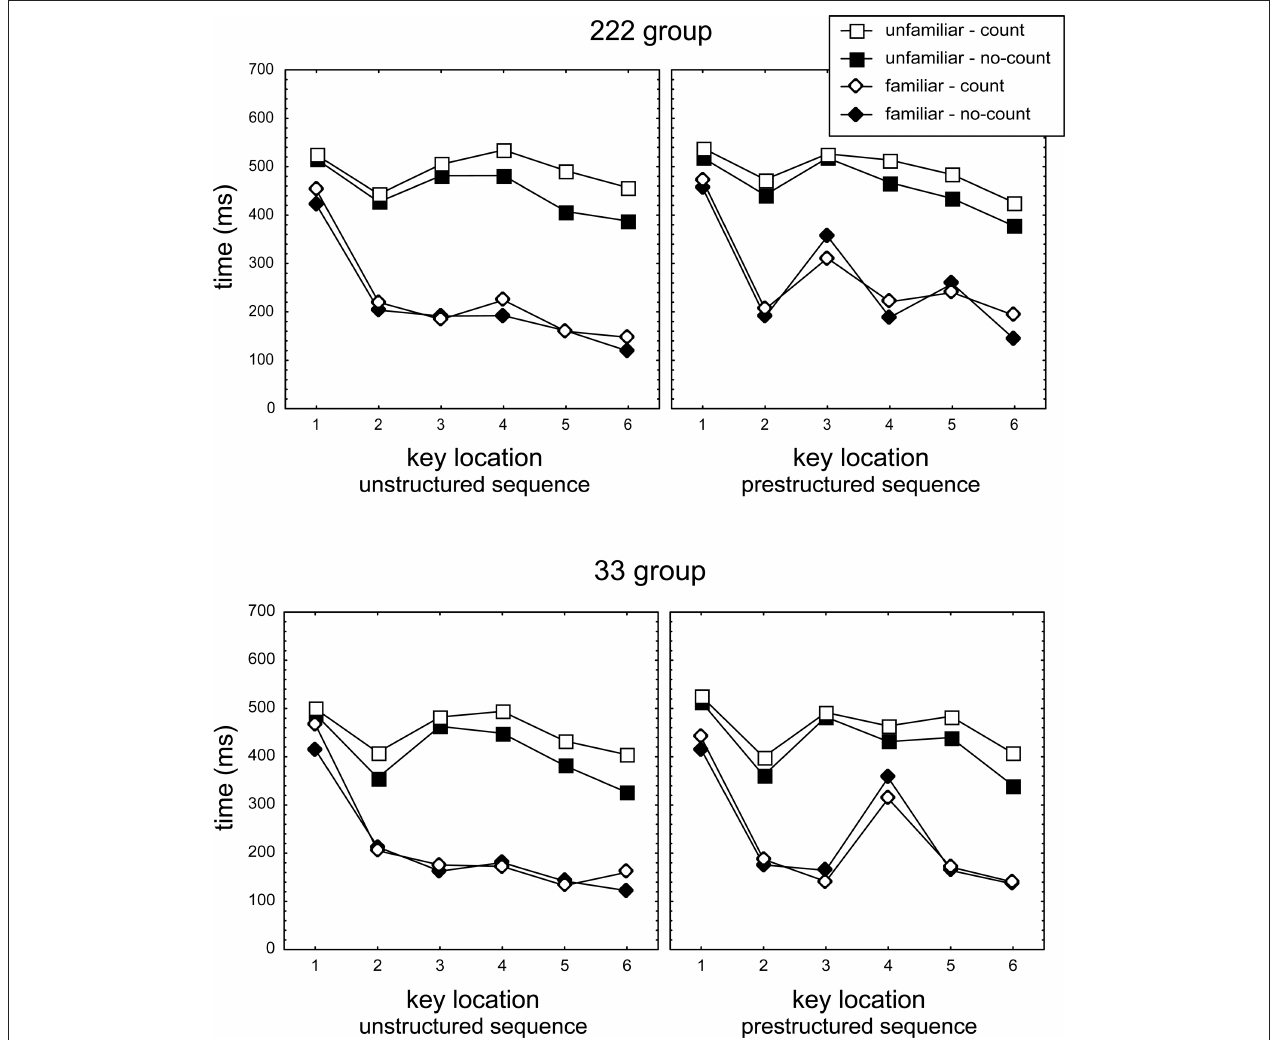
Figure 2 | response times (i.e., T counting conditions of the test phase for the unfamiliar and familiar (prestructured and unstructured) sequences. T